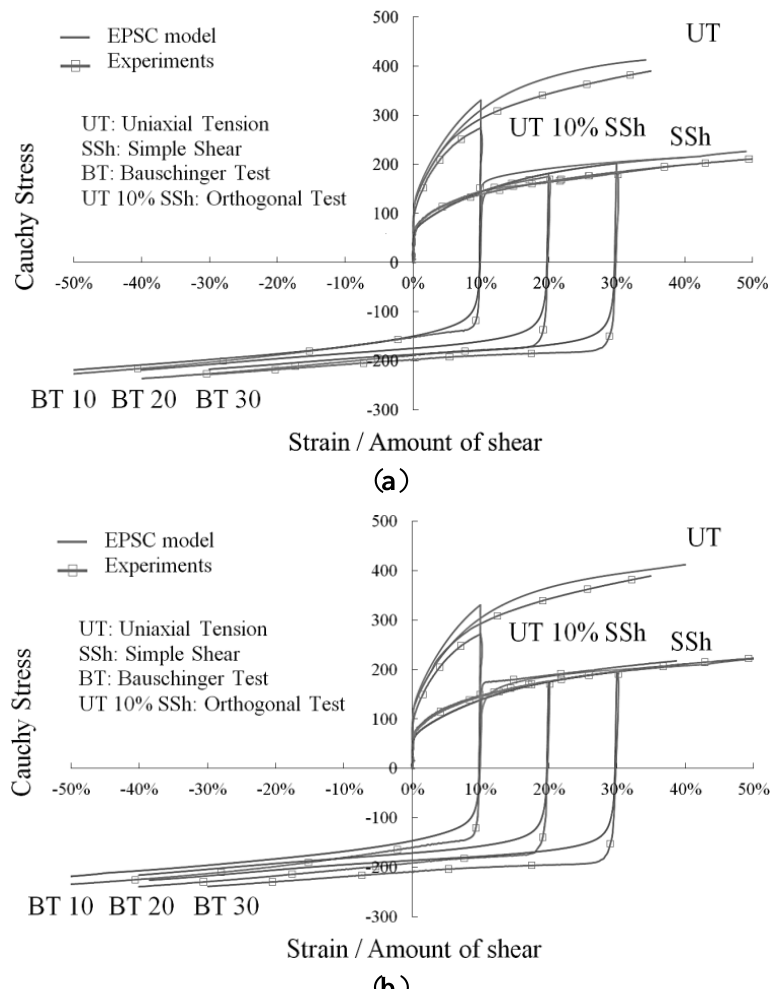
Figure 3. Comparison model/experiments for the stress–strain response of an IF–Ti steel along various strain paths performed: ( a ) at 45° with respect to RD, ( b ) at 90° with respect to